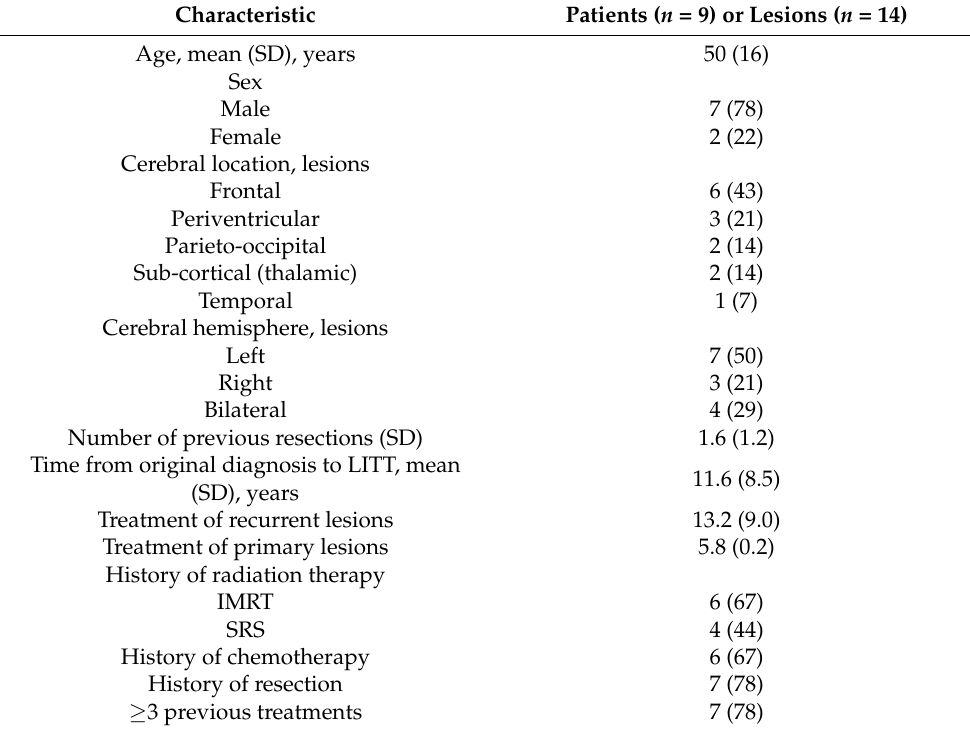
Table 2. Demographics and lesion characteristics of 9 patients with low-grade glioma (LGG) and radiation necrosis (RN) treated with laser interstitial thermal therapy (LITT). Characteristic Patients ( n = 9) or Lesions ( n =